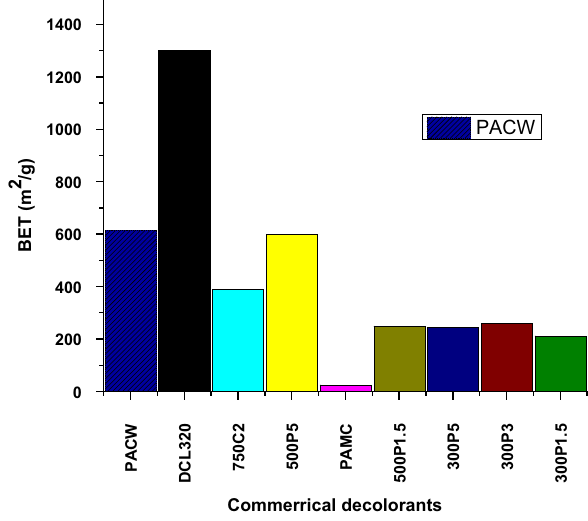
Fig. 5 Surface area parameters comparison between PACW and other